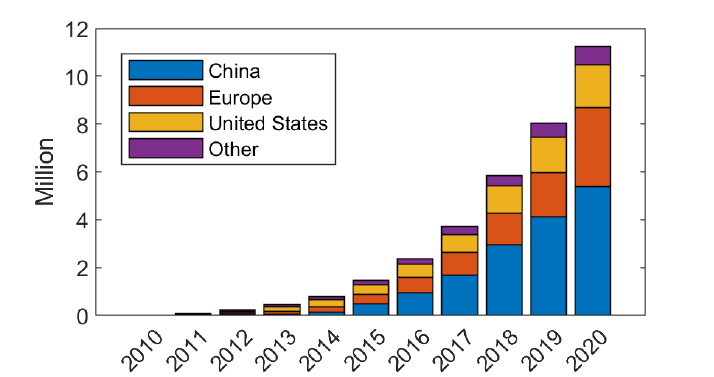
Figure 1. Global electric vehicle stock by region, 2010–2020 [1]. Table 1. EV charger power levels adapted from [3–6].